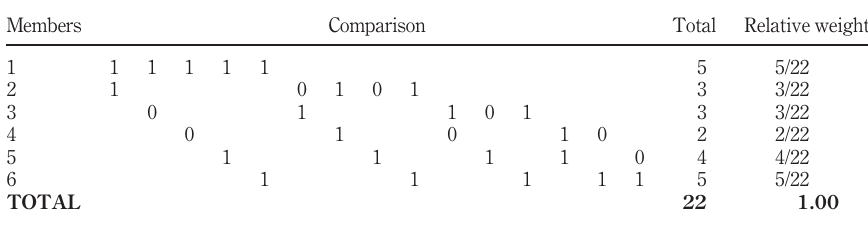
5. Decision Making: Table 5 Paired comparison chart of each member on ‘ Decision Making ’